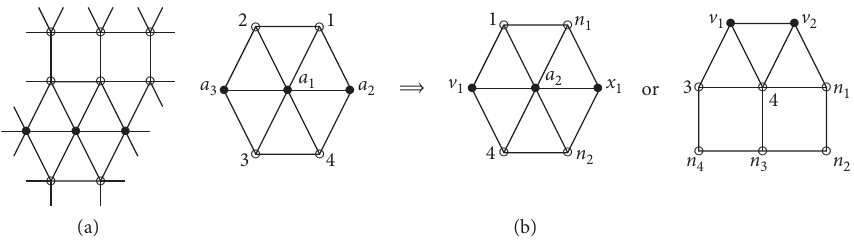
Figure 2: Illustration of the methodology. (a) DSEM type: [3 6 : 3 3 , 4 2 ]